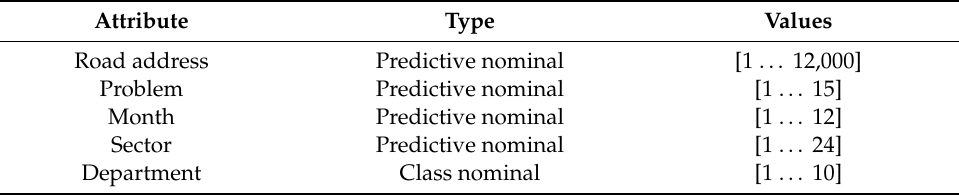
Table 2. Cholargos municipality section dataset